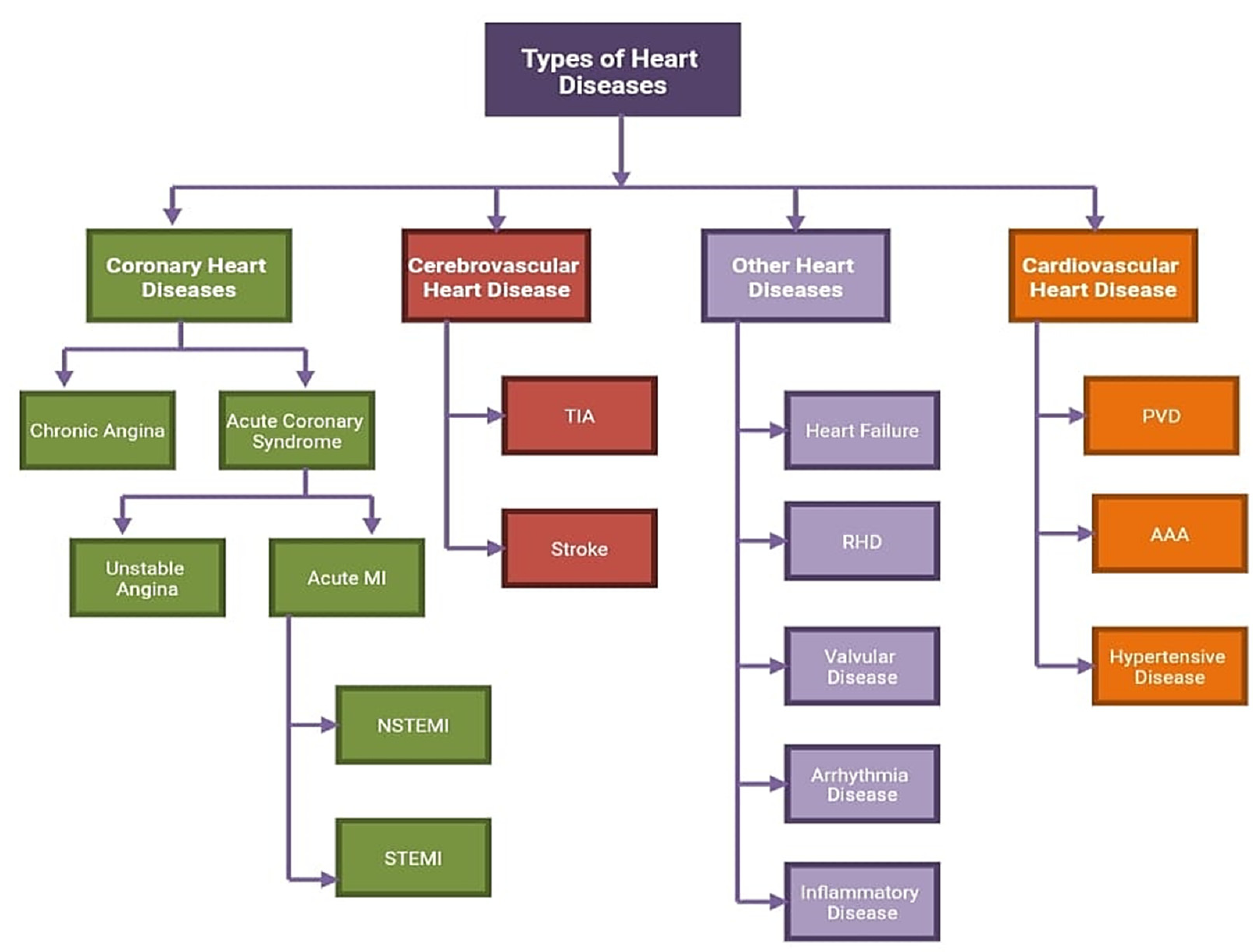
Figure 2. Types of Heart diseases.